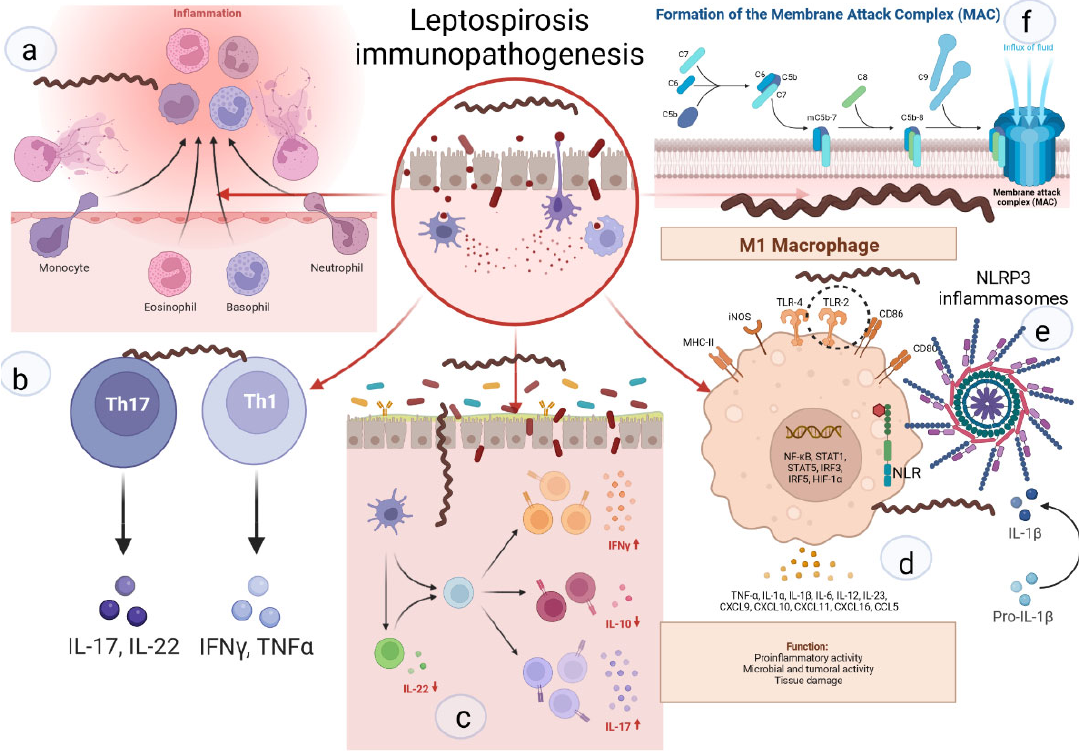
Figure 2. Key links in the immunopathogenesis of leptospirosis: ( a ) recruitment of neutrophils to the inflammatory zone and formation of NETs; ( b ) activation of differentiation of pro ‐ inflammatory subpopulations of T ‐ helpers; ( c ) increase in pro ‐ inflammatory signaling against the background of deficiency of suppressor signals and Treg cells; ( d ) activation of M1 ‐ macrophages, stimulation of TLR2; ( e ) NLR with subsequent formation of NLRP3 ‐ inflammasome and subsequent maturation of IL1b; ( f ) ‐ formation of MAC and destruction of the cell membrane.